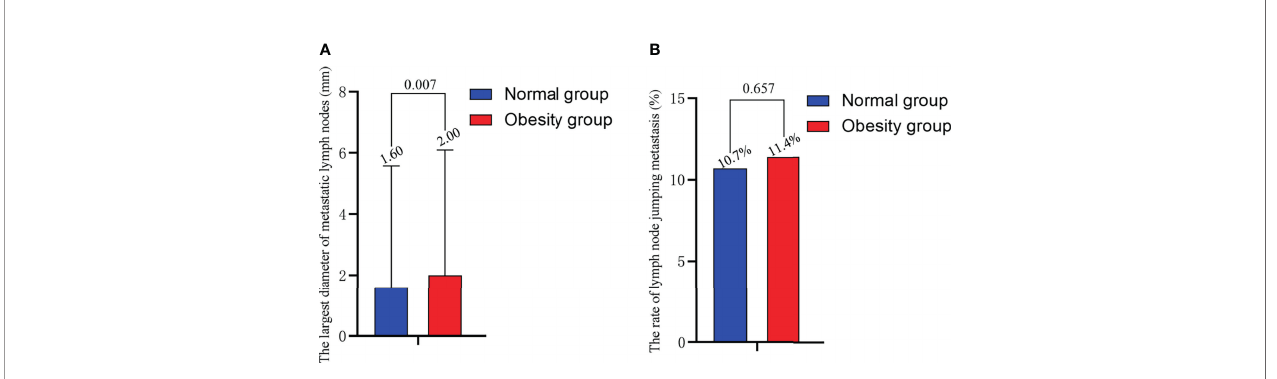
FIGURE 2 | Relationship of obesity with (A) the maximum diameter of positive LN and (B) the rate of LN skip metastasis. BMI, body mass index; LN, lymph node.